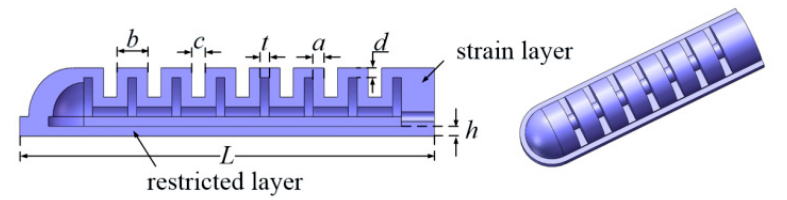
Figure 2. Structure of the bending actuator.